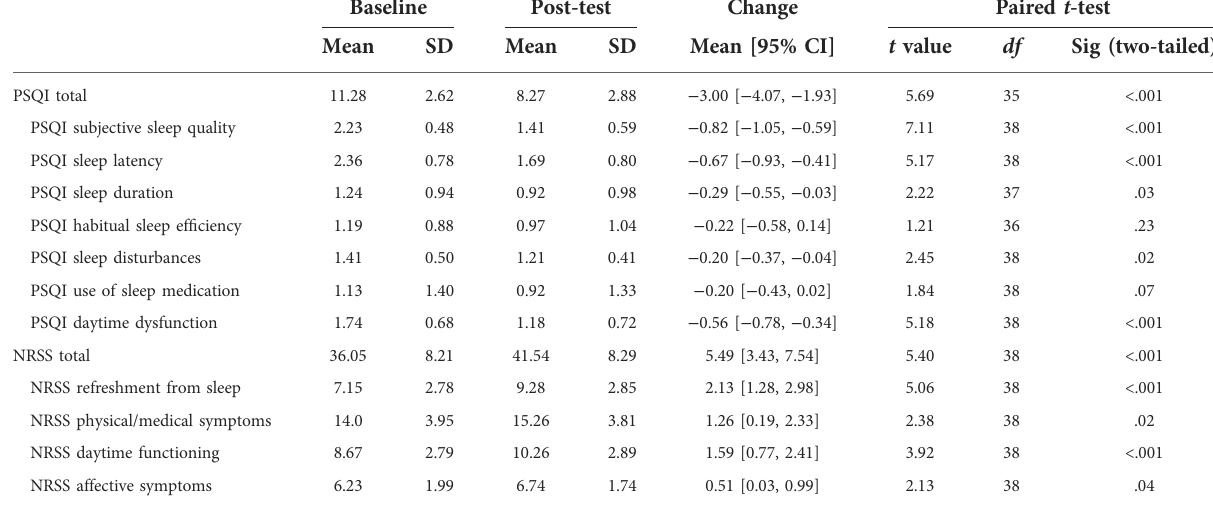
TABLE 4 Scores on the Pittsburgh Sleep Quality Index (PSQI) and Non-Restorative Sleep Scale (NRSS) subscales at baseline and after the